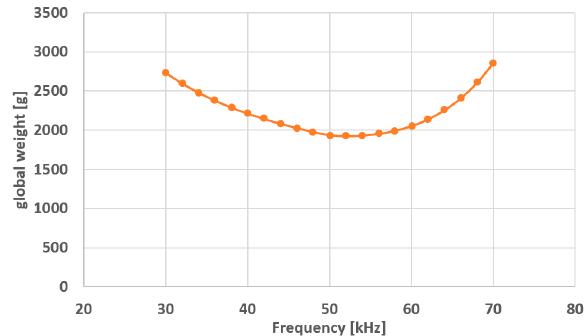
Figure 15. Optimal weight at 97.8% efficiency with imposed switching frequencies.